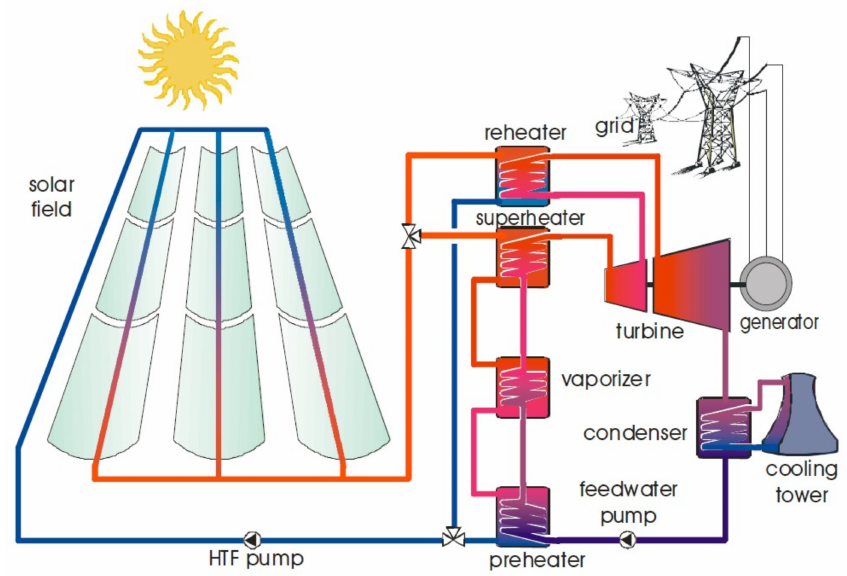
Figure 1. Scheme of the working principle of a CSP plant equipped with parabolic trough collector receiver and connected to a power cycle system, adapted from [11].